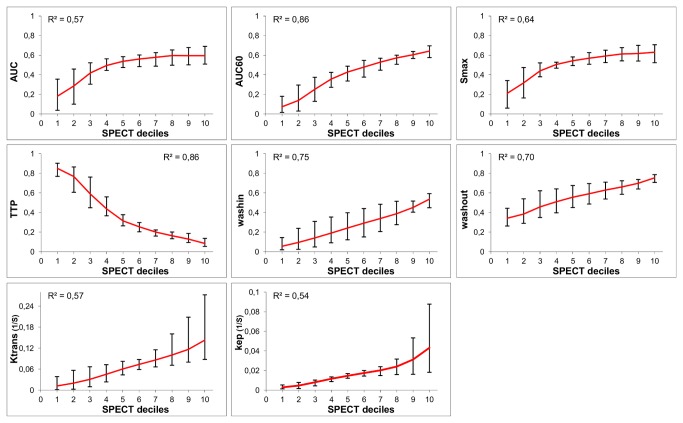
Linear regression analysis on the grouped datasets.The median value per parameter for the SPECT decile bins calculated over all datasets, together with highest and lowest median value per parameter from the 4 individual datasets, and R2 value per parameter from linear regression analysis (p<0.05). AUC, area under the whole curve; AUC60, area under the curve for the first 60 s; Smax, maximum enhancement; TTP, time to peak; wash-in, slope between the 10% point and the 90% point on the enhancement curve [19]; wash-out, slope between the point of maximum enhancement and the last time point [19]; Ktrans (s-1) capillary transfer constant [20]; kep (s-1), contrast exchange rate [20]. Semi-quantitative parameters were normalized.